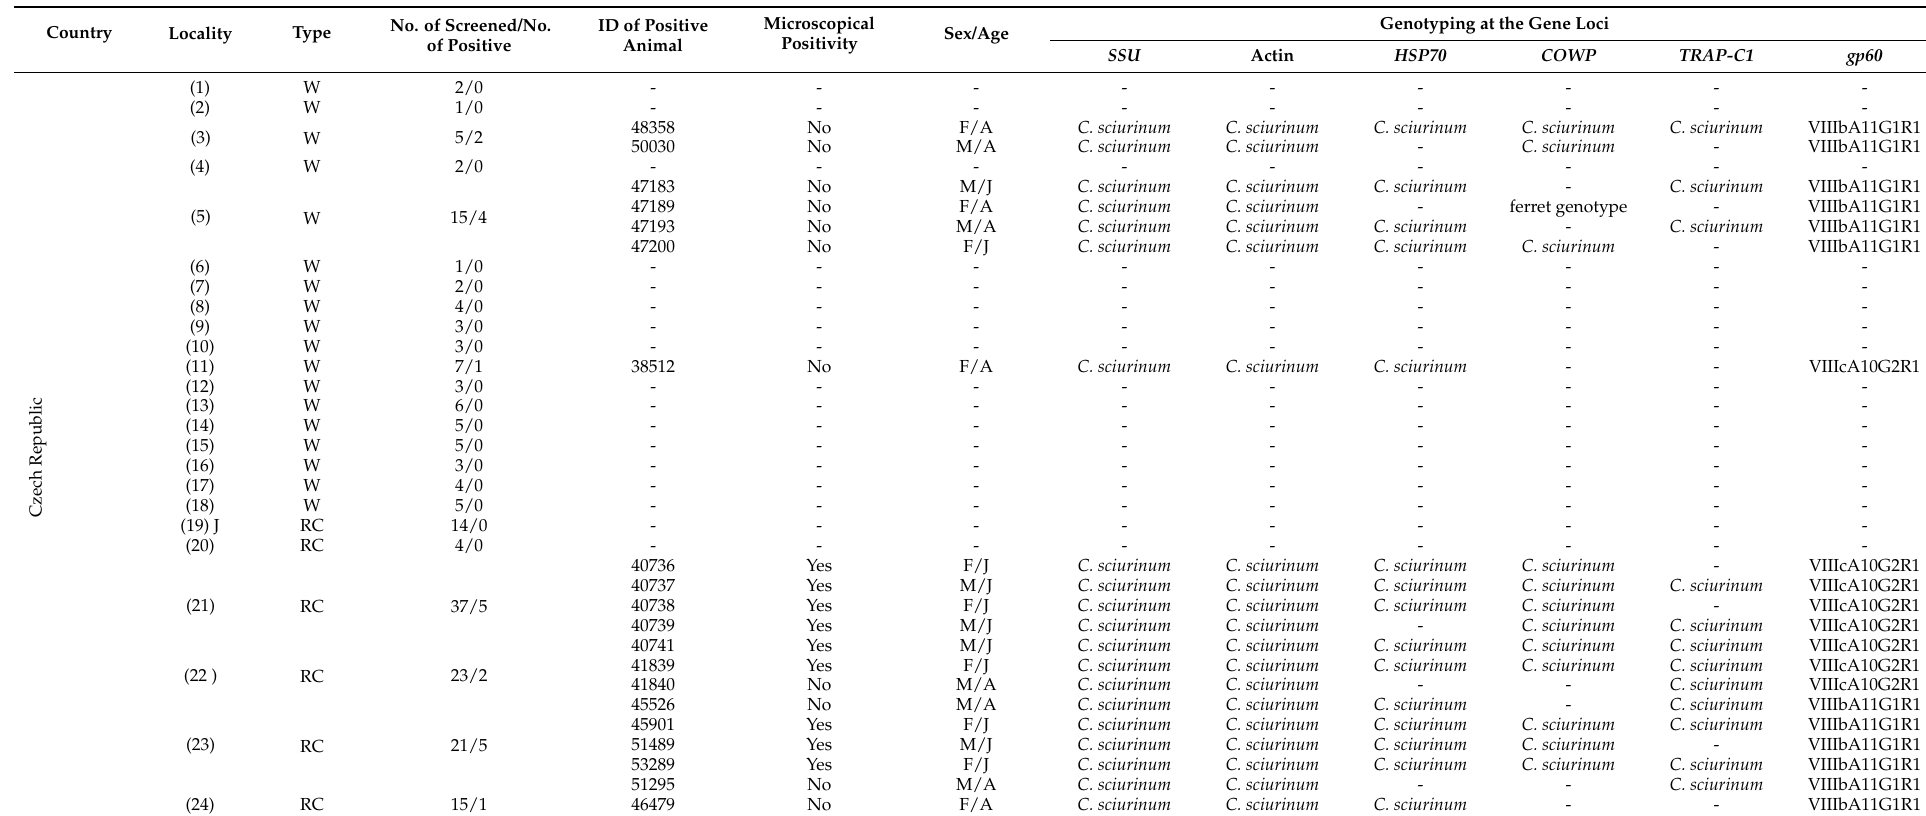
Table 1. The occurrence and genetic diversity of Cryptosporidium spp. in Eurasian red squirrels ( Sciurus vulgaris ) trapped in the wild (W) and screened at rescue stations (RS) in the Czech Republic and Slovakia. Detected isolates were genotyped by sequence analysis of the small subunit ribosomal rRNA ( SSU ), actin, 70 kDa heat-shock protein ( HSP70 ), thrombospondin-related adhesive protein of Cryptosporidium -1 ( TRAP-C1 ), Cryptosporidium oocyst wall protein ( COWP ), and 60 kDa glycoprotein ( gp60 ) gene fragments. Oocysts were quantified by microscopy and were reported per gram of faeces